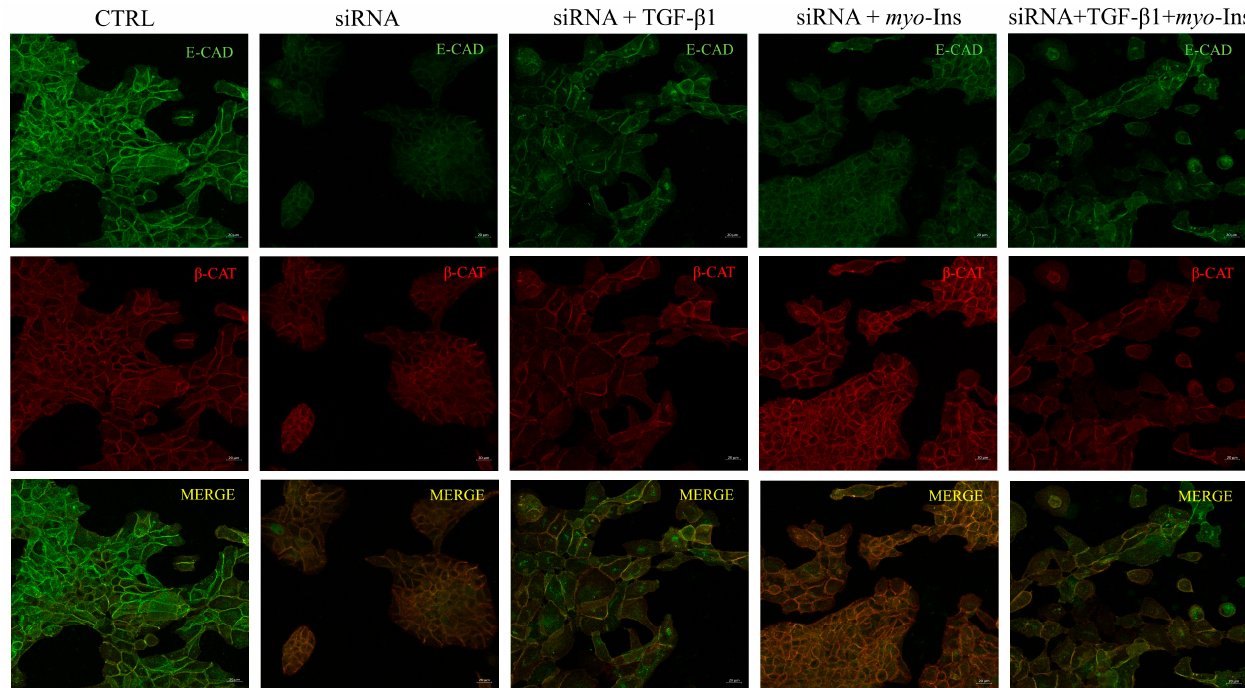
Figure 10. Analysis of E-cadherin and β -catenin distribution. Immunofluorescence analysis of E- cadherin (green) and β -catenin (red) in MCF-10A cells transfected with E-cadherin siRNA and then treated with myo-Ins, TGF- β 1 alone, or a sequential association of the two factors. In contrast to the results obtained in the absence of transfection with E-cadherin siRNA, myo-Ins was unable to reverse the effects induced by TGF- β 1. Restoration of E-cadherin– β -catenin complexes only marginally occurs, and cells remain detached and scattered all around. F-actin distribution is only partially improved, and stress fibers are still visible. Overall, images suggest that the reconstitution of E- cadherin– β -catenin structures is a mandatory step to achieve EMT reversion upon myo-Ins treatment. Images were scanned under a 20 ×